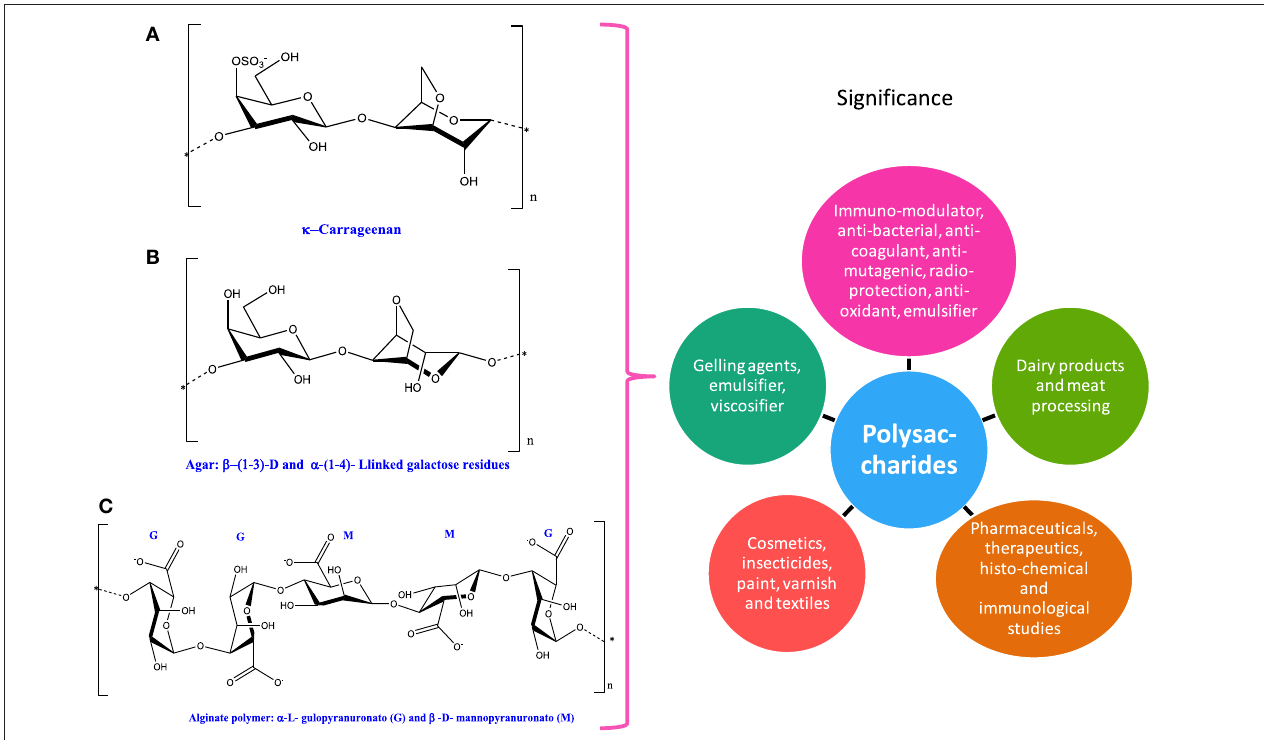
FIGURE 5 | Chemical structures and significance of phycocolloid compound: (A) carrageenan, (B) agar, and (C) alginate polymer obtained from different cyanobacteria and